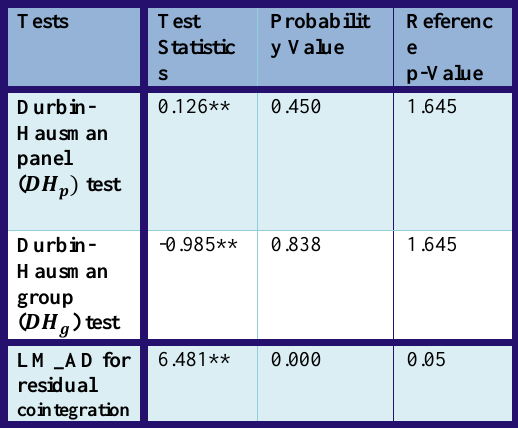
Table 4: Cointegration Test Results for Companies Traded in Turkey